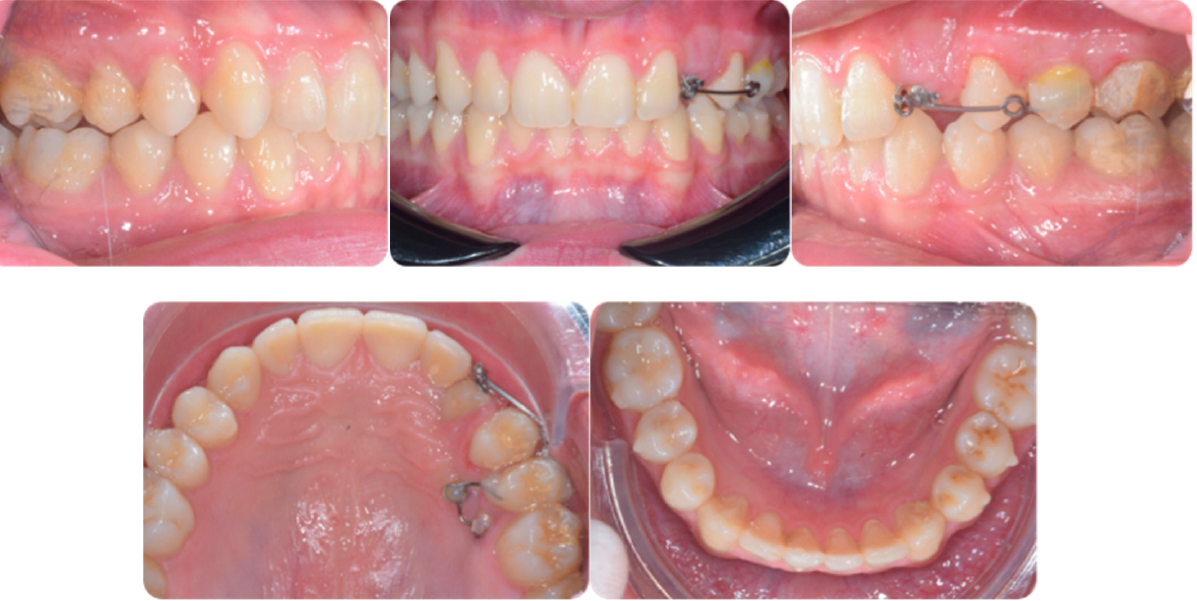
Figure 5. A bonded composite connection between the impacted canine (premolars and premolar) and the mini-screw.